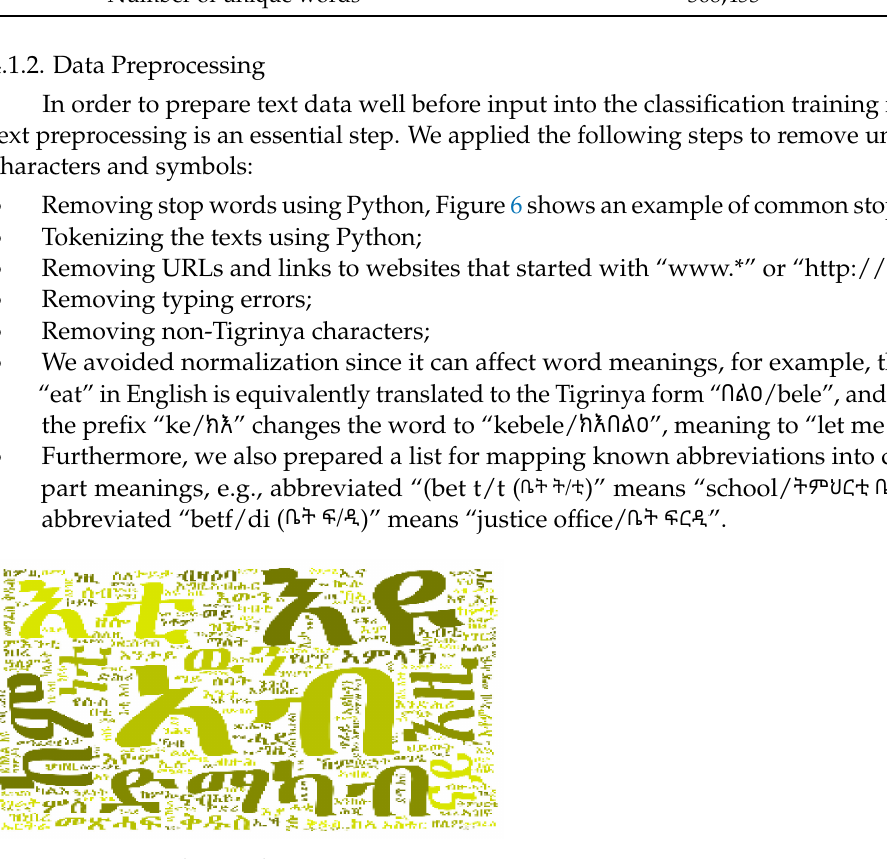
Table 3. Detailed summary of the word embedding collection.